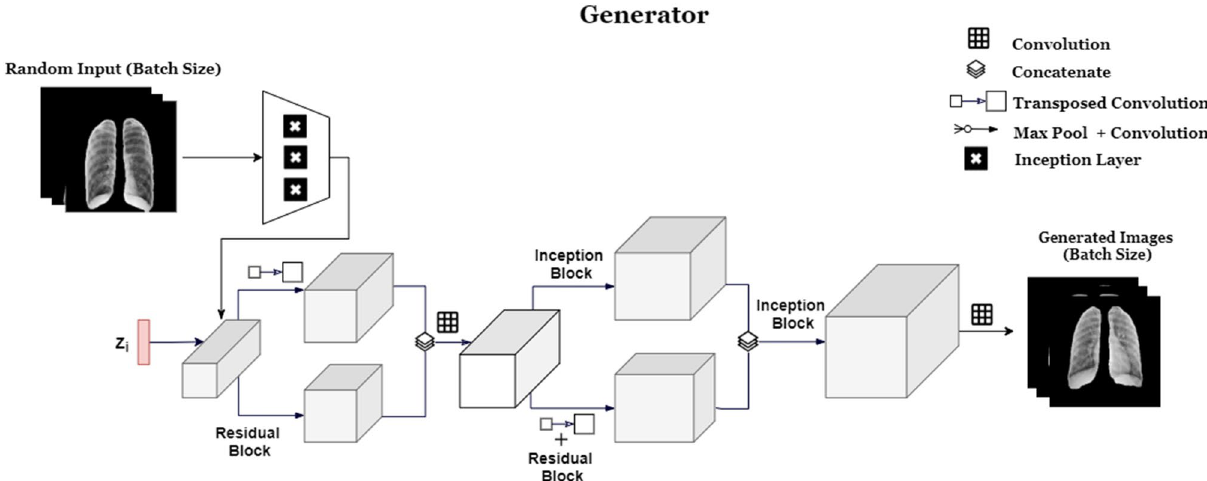
Figure 3. RANDGAN’s generator